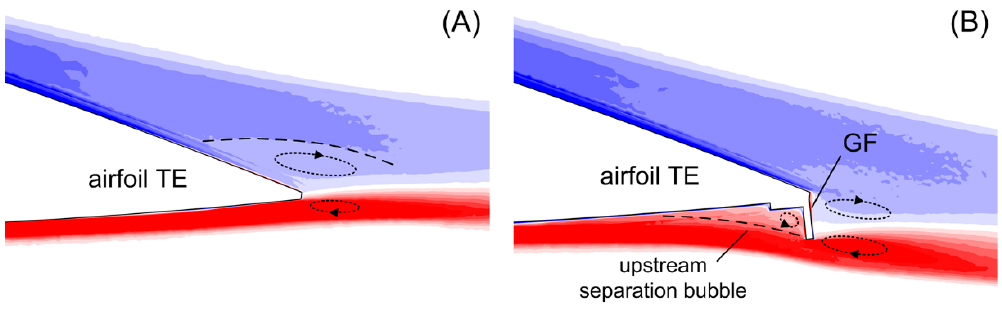
Figure 1. ( A ) Flow field around smooth airfoil; ( B ) flow field around an airfoil with a Gurney flap (field data of vorticity from numerical calculation of the